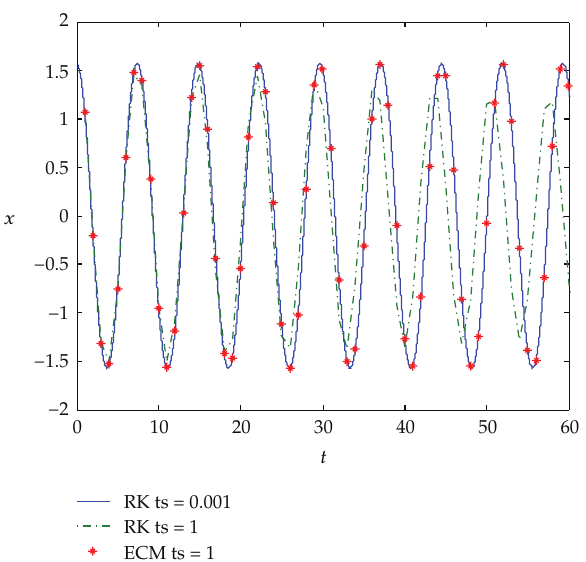
Figure 1: Angular Displacement comparison between the proposed energy conservation method (cid:2) ECM (cid:3) and the RK method.